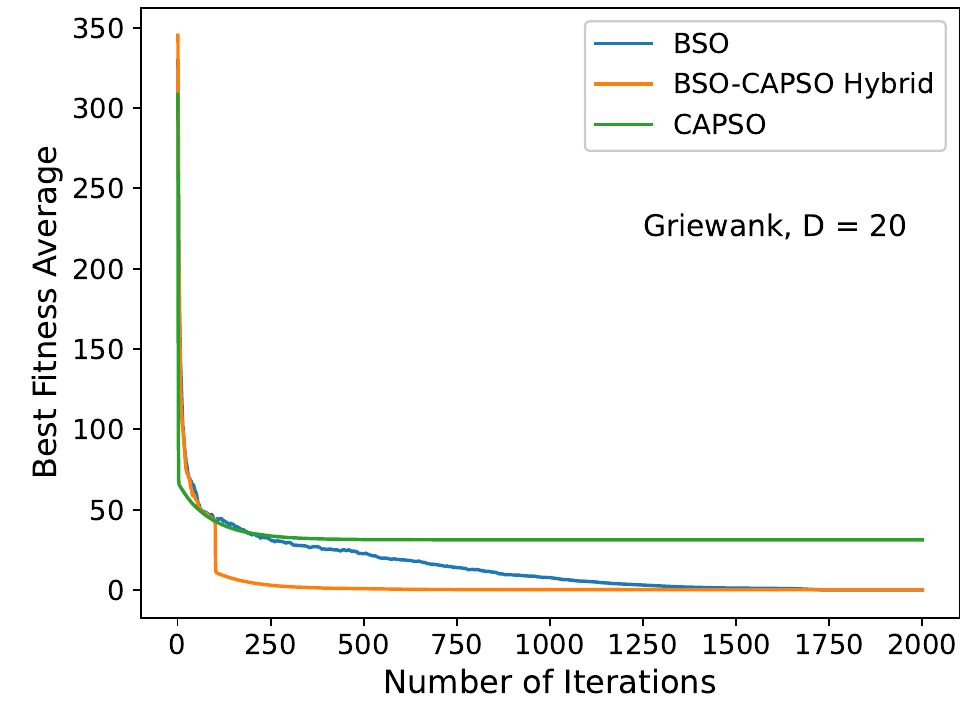
Figure 5. Convergence diagram of the stand-alone BSO, BSO–CAPSO hybrid and stand-alone CAPSO algorithms for the Griewank ( f 6 ) function with D = 20. Convergence acceleration occurred after t switch =